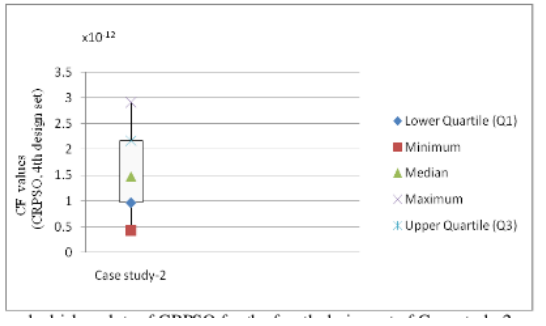
Figure 13: Box and whisker plots of CRPSO for the fourth design set of Case study-2 over 50 trial runs.